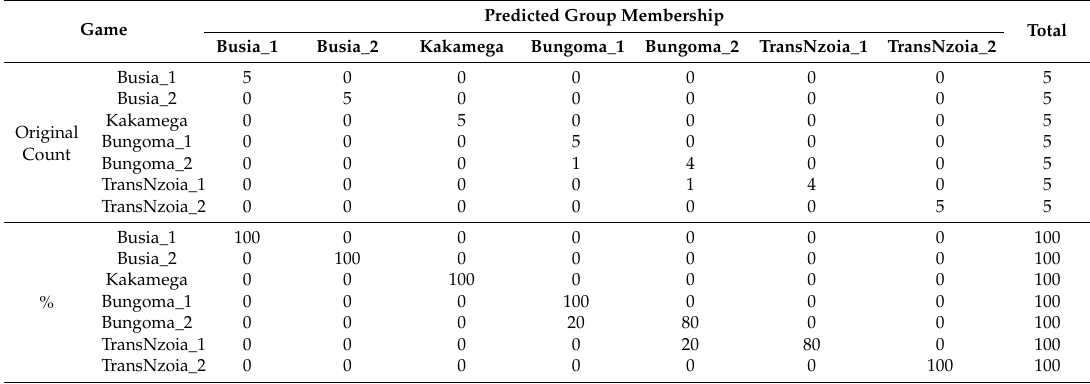
Table A14. Classification results.